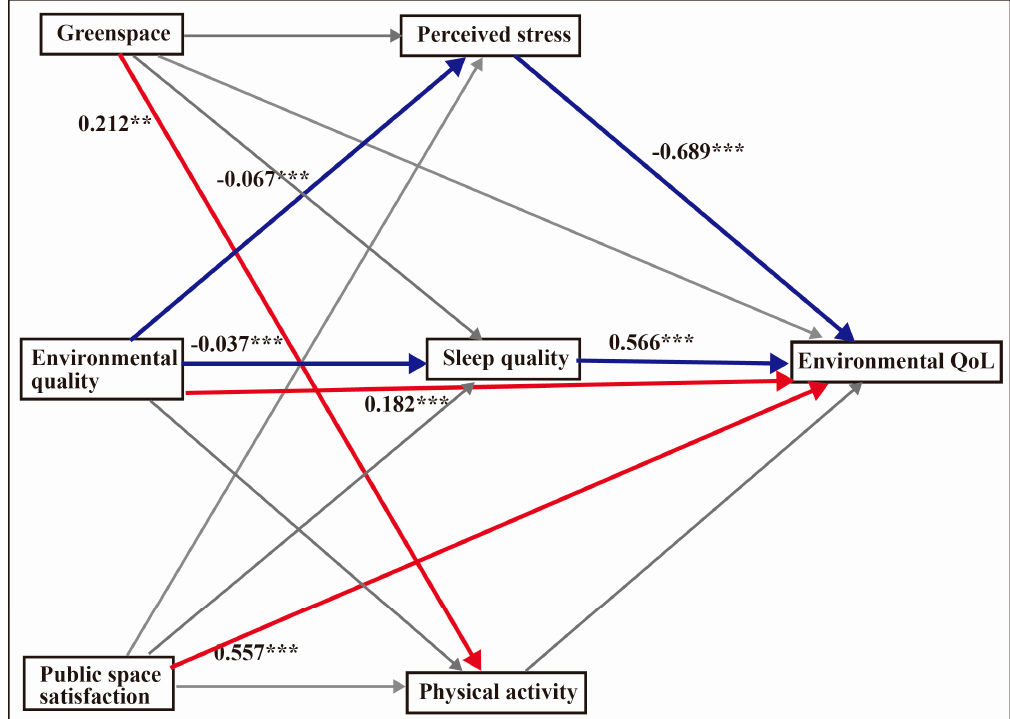
Figure 4. Mediation model for environmental QoL. The analyses controlled for fruit intake and education level. Unstandardised coefficients are displayed. The values indicate the strength of the relationship between variables. Red arrows depict positive relationships, blue arrows show negative relationships and grey arrows depict non-significance. ** p < 0.01, *** p < 0.001.